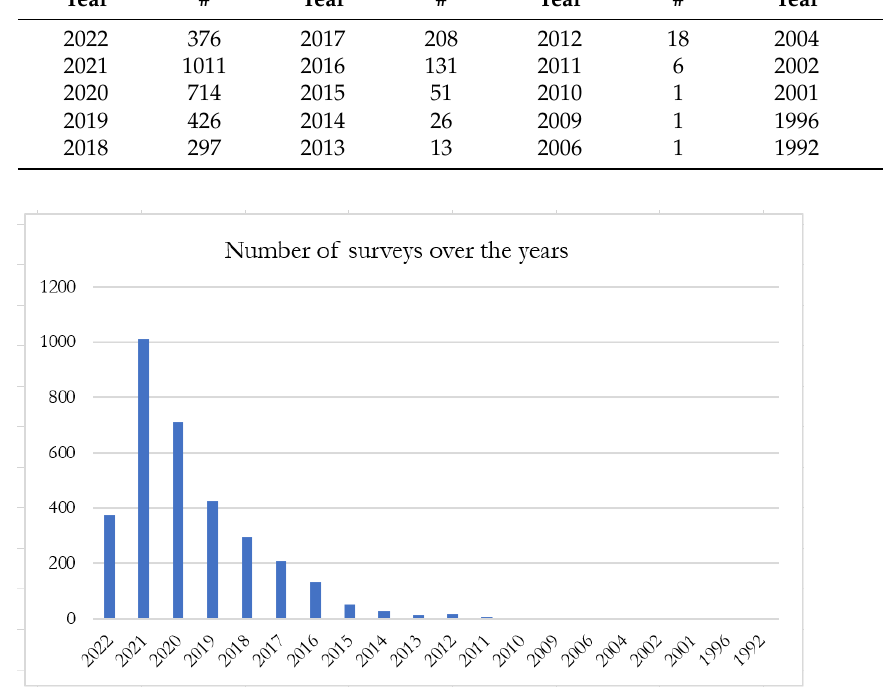
Figure 11. The graph of the reviews archived into Scopus.